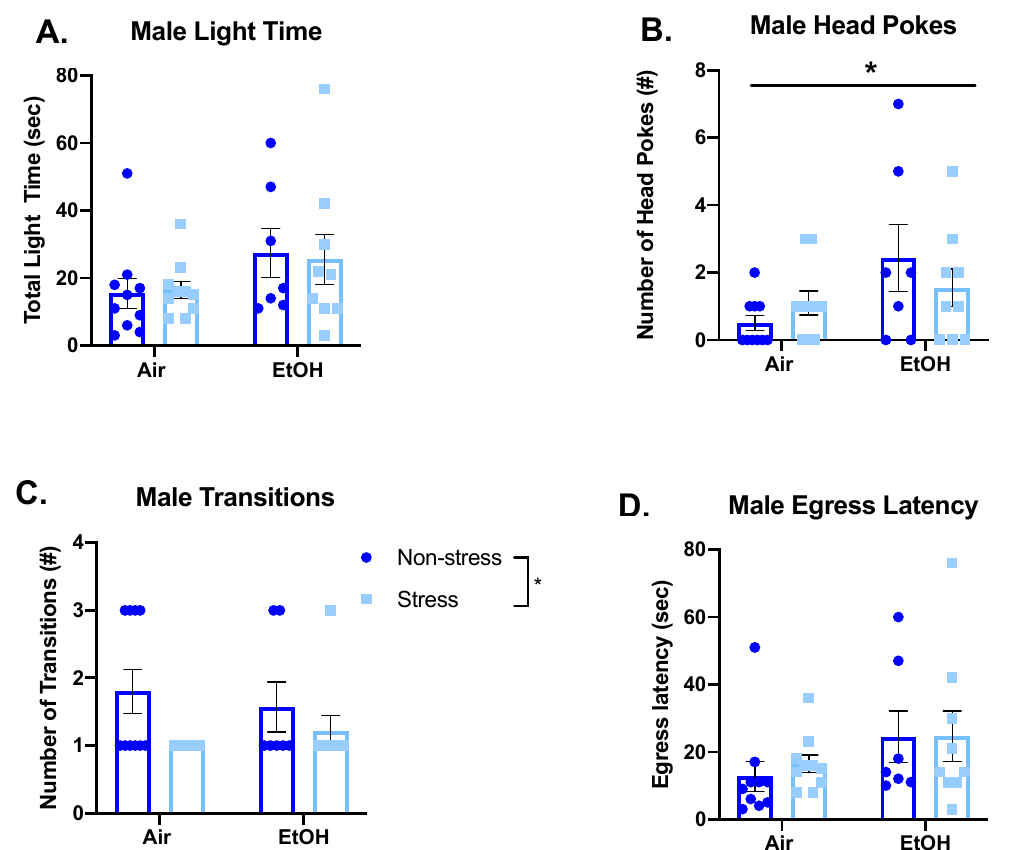
Figure 6. Comparison of male anxiety ‐ like behaviors measured in the light–dark box by adolescent air or ethanol (EtOH) exposure in the non ‐ stress group or following two days of forced swim stress, namely time spent in the light side ( A ), frequency of head pokes into the light side ( B ), number of transitions between the light and dark side ( C ), and latency to first cross into the dark side ( D ). Ethanol-exposed males showed a significant increase in number of head pokes, and stressed males showed a significant decrease in number of transitions. Significant main e ff ects are denoted as * p < 0.05. Similar to males, females did not show any significant di ff erences among di ff erent exposure conditions for total time spent in the light side (Figure 7A; ethanol: F (1,35) = 0.3229, p = 0.574; stress: F (1,35) = 1.859, p = 0.182; interaction: F (1,35) = 0.185, p = 0.670). Additionally, there were no significant e ff ects among females for number of head pokes (Figure 7B; ethanol: F (1,35) = 0.001, p = 0.995; stress: F (1,35) = 0.291, p = 0.593; interaction: F (1,35) = 0.345, p = 0.561), number of transitions (Figure